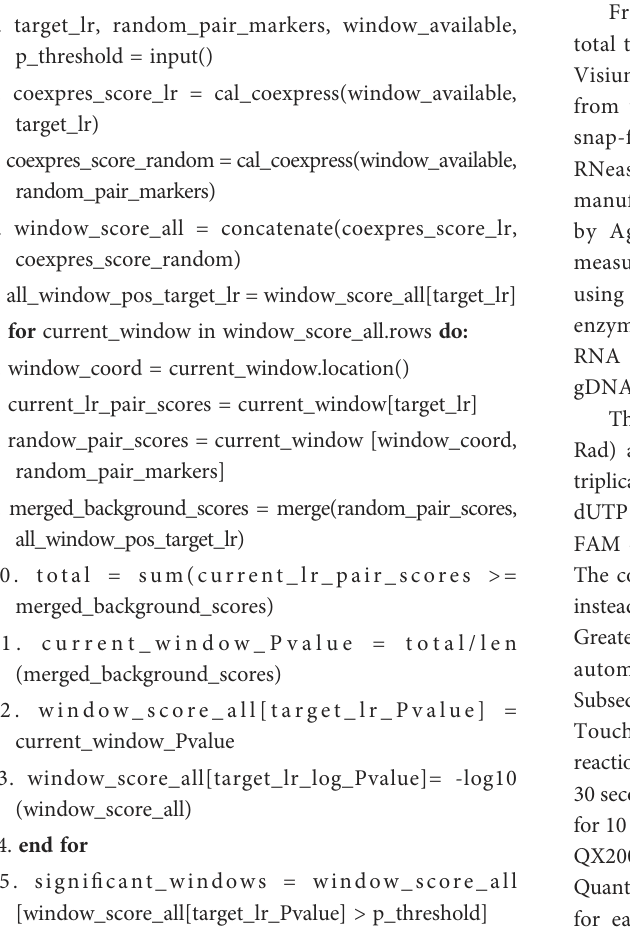
Algorithm 2: Quantifying local co-expression and statistic